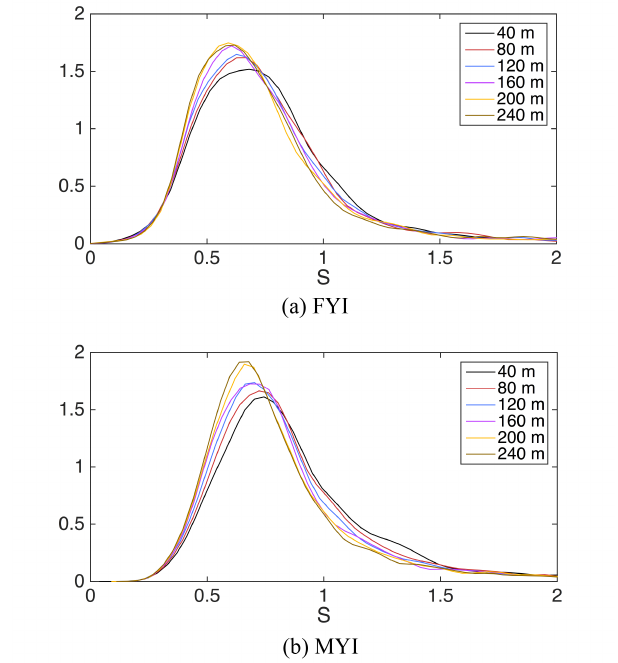
Figure B3. Scaling of the distribution of s . Through coarsening the measurement of snow depth and snow freeboard with adjacent points, the value of s is computed for each spatial scale with the nonlinear fitting in Sect. 3.1. The distribution of s is computed us- ing all available data from OIB